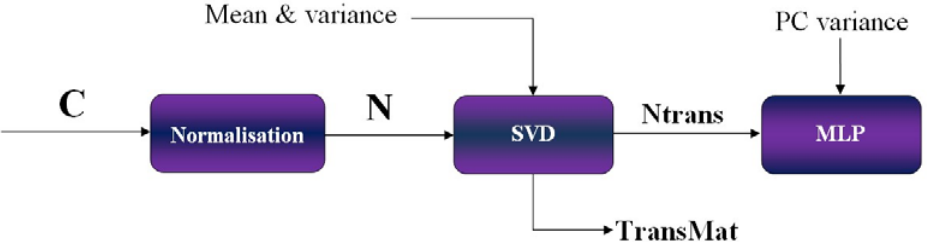
Figure 10. Schematic diagram of pre-processing of ECT